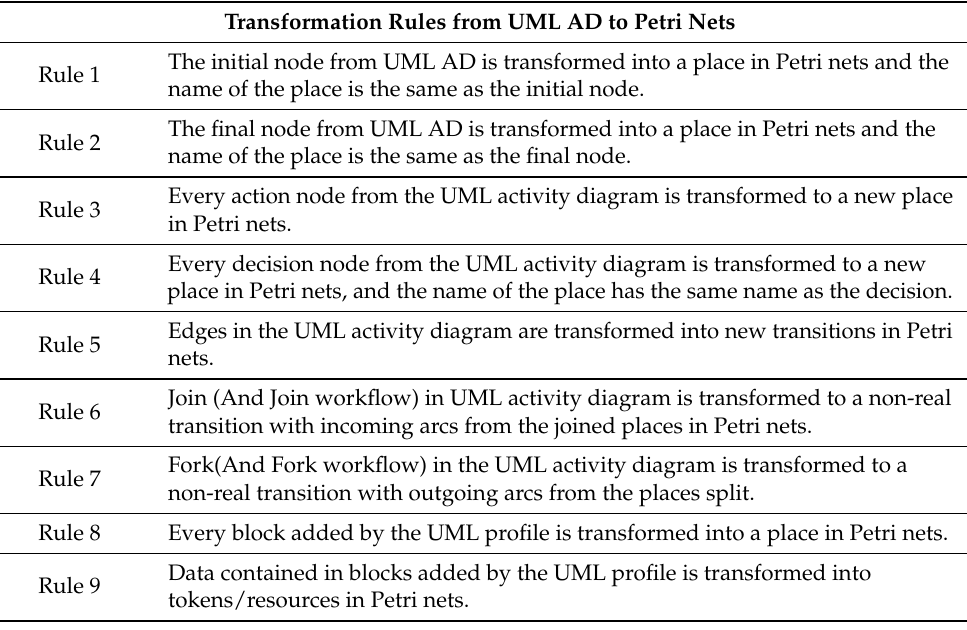
Table 3. Transformations rules from UML AD to Petri